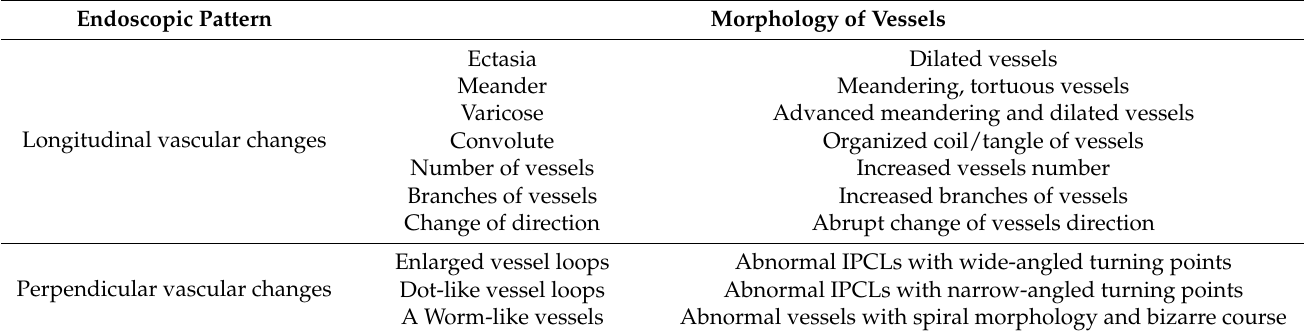
Table 2. Classification according to the European Laryngological Society by Arens et al. (2016)